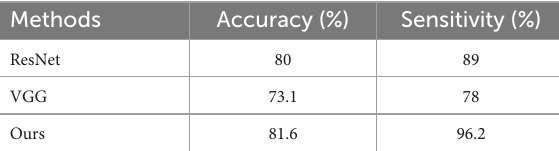
TABLE 1 Comparison of the classification results of malignant lung nodules with different methods.